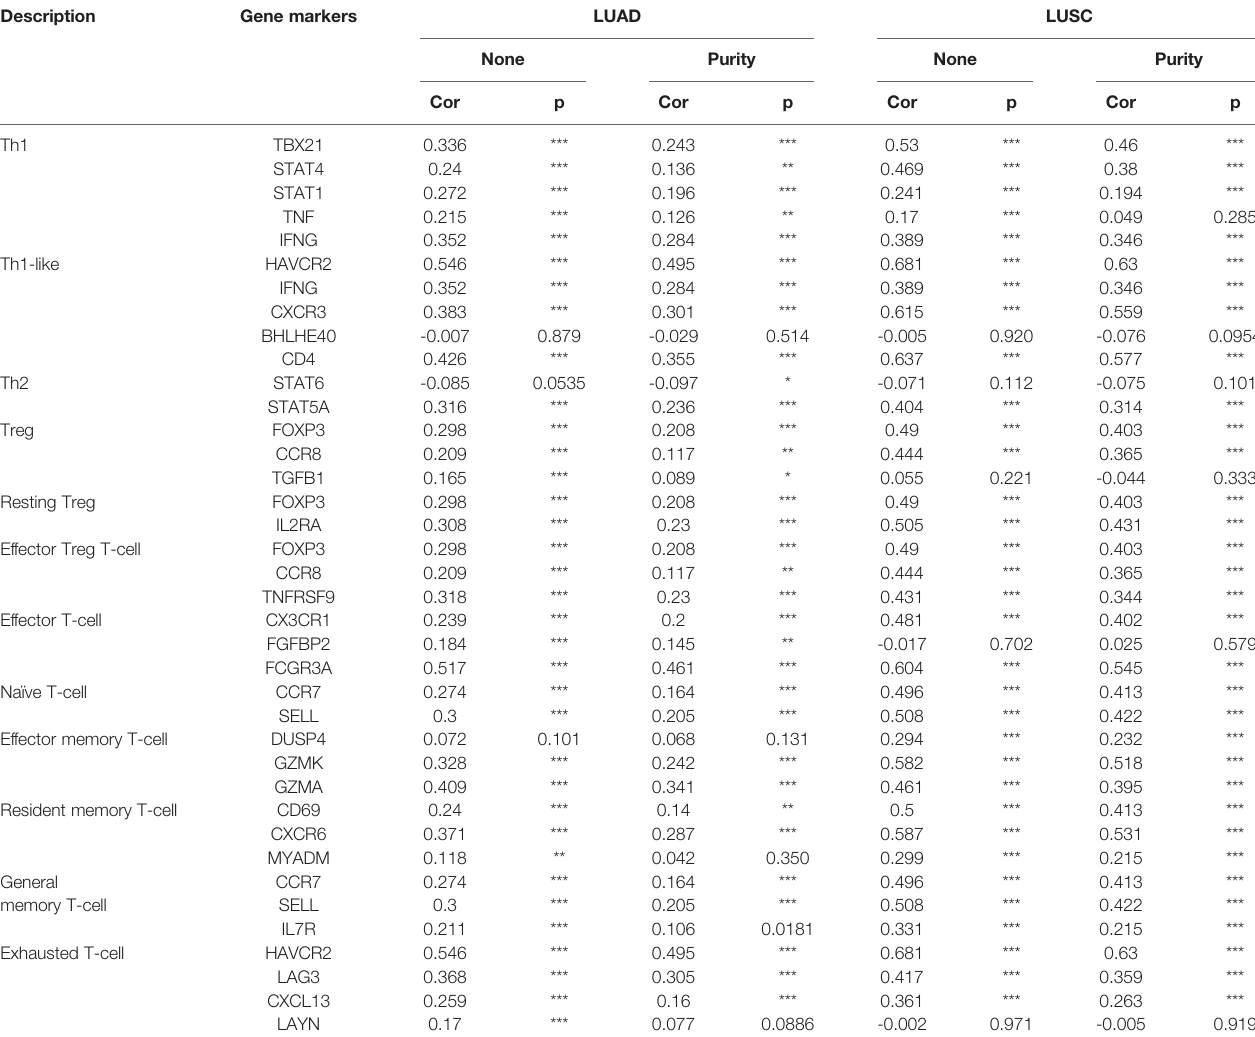
TABLE 2 | Correlation analysis between hepcidin and gene markers of different types of T cells in TIMER.